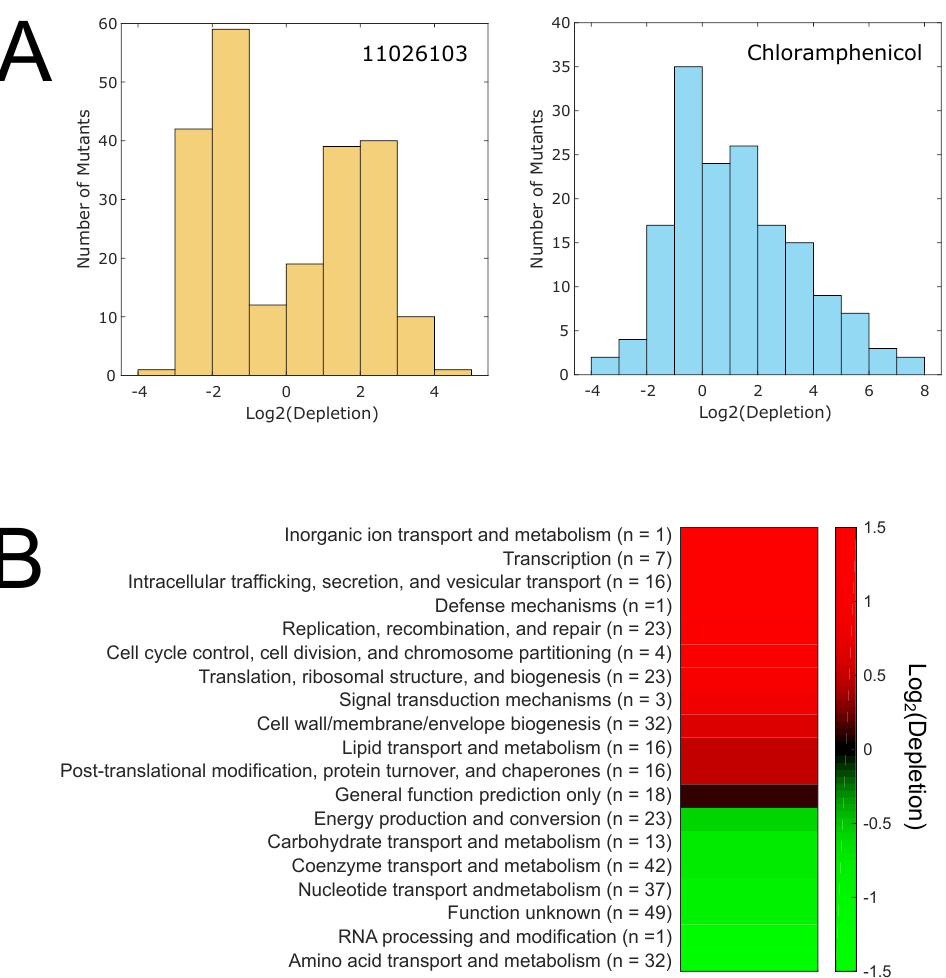
Figure 4. E ff ect of 11026103 on essential gene knockdown mutants. ( A ) The bimodal distribution of genes a ff ected by 11026103. Normal distribution, resulting from chloramphenicol treatment, is shown for comparison. Abundance of each mutant relative to the no antibiotic control was calculated by taking the log 2 of the normalized read count for the control divided by the normalized read count for the 11026103- or chloramphenicol-treated sample. Positive values indicate susceptibility. ( B ) Cluster of orthologous groups (COG) categories a ff ected by 11026103. The values for individual genes per COG category were averaged. The total number of genes recovered after the growth with 11026103 is shown for each COG